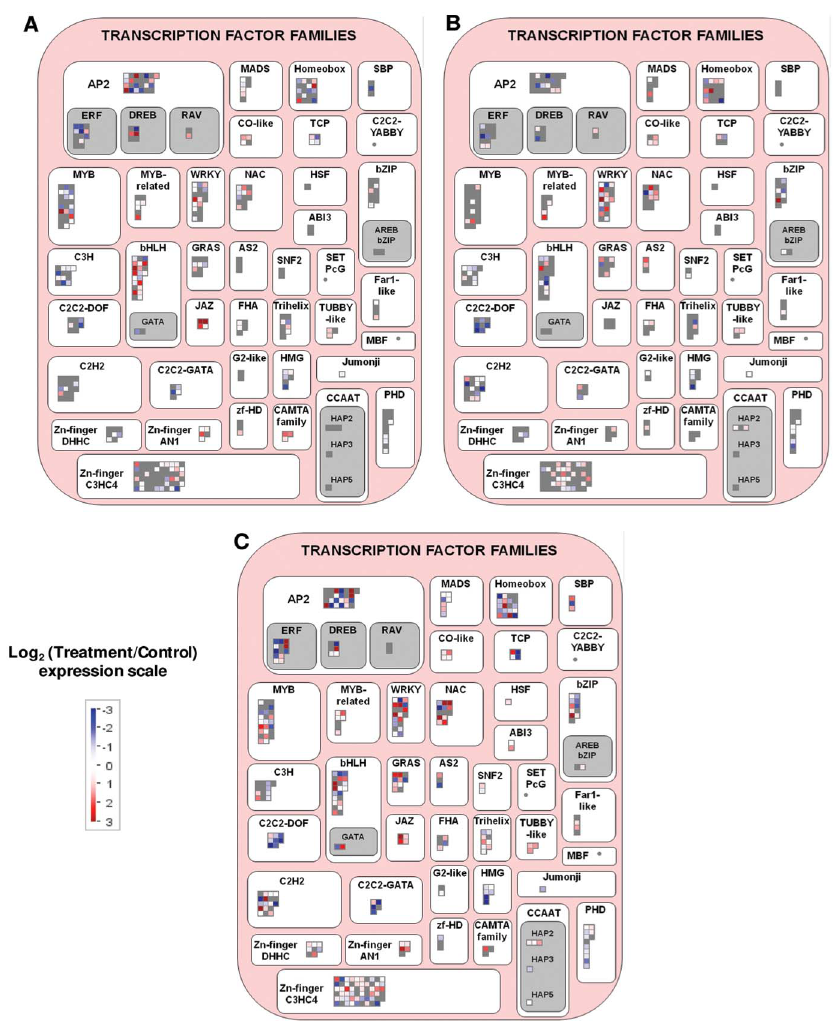
Figure 6. Mapman visualization of the significant genes in the ‘Transcription factor families’ functional category. A, MJ (methyl jasmonate); B, CD (cyclodextrins); C, CDMJ (cyclodextrins and methyl jasmonate). Resultant transcripts were considered after the average of significant redundant probesets expression values. Significant probesets according to a 5% FDR and P -value , 0.05 for model variable in the corresponding control versus treatment 24 h series maSigPro comparison. Expression changes in the treatment normalized to these in the control are shown. Red, treatment up-regulated transcripts; blue, treatment down-regulated transcripts; grey, transcripts not significant in the treatment.